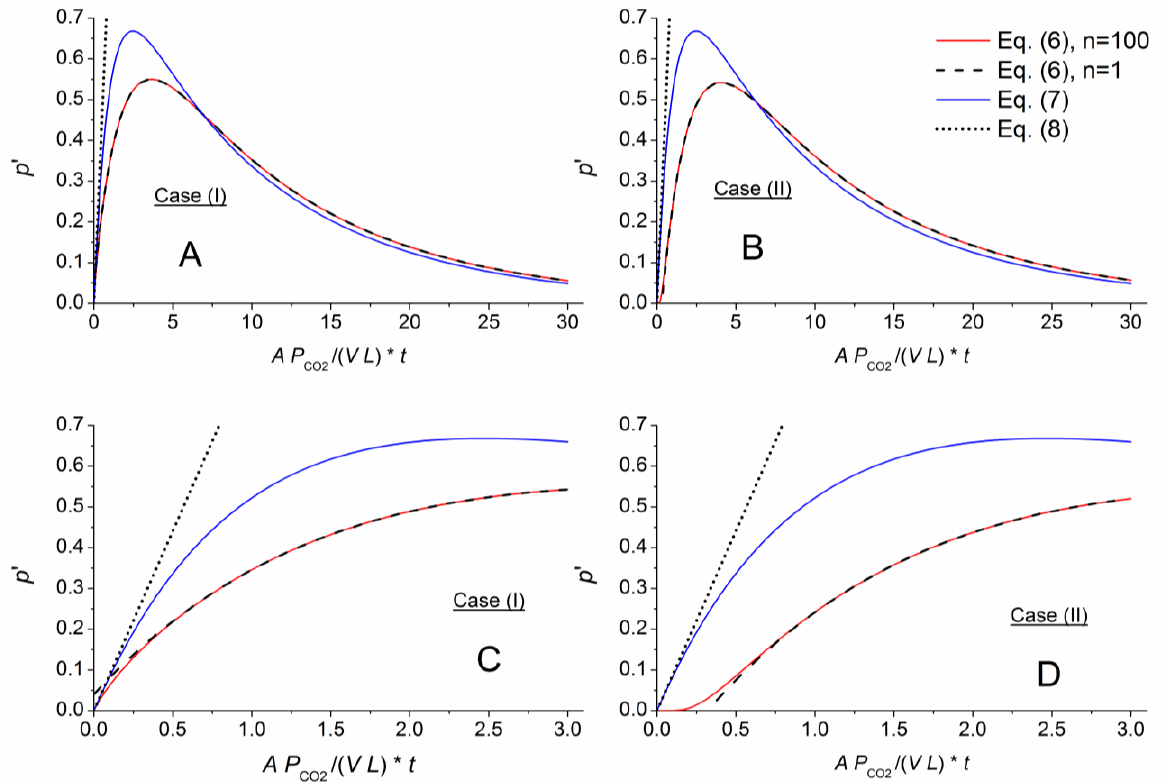
Figure 4. Comparison of the exact and approximate solutions for 1/  VAL (same scenario described for Figure